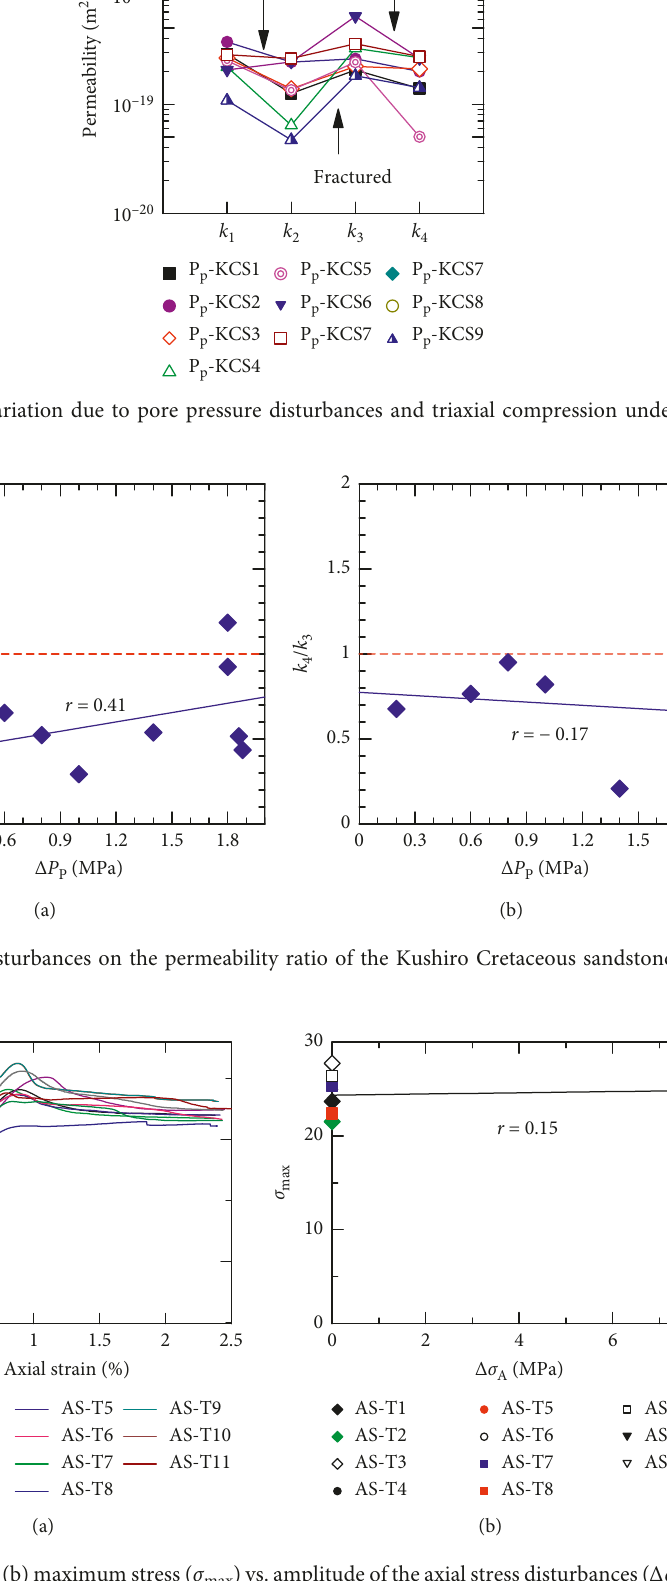
max ) vs. amplitude of the axial stress disturbances (